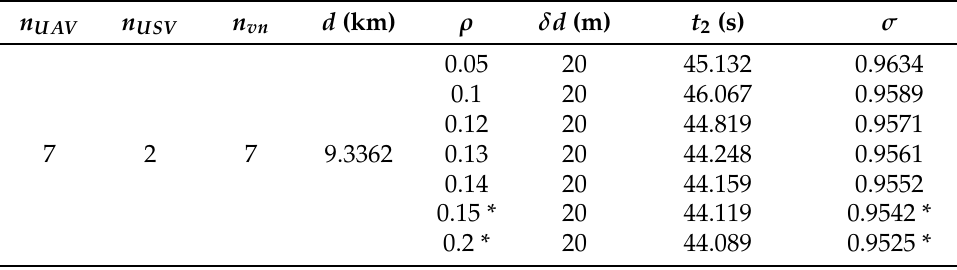
Table 14. Algorithm results: execution time (after time execution improvement) and performance indicator σ ( nt = 3, LB = 106 dB, d = 9.3362